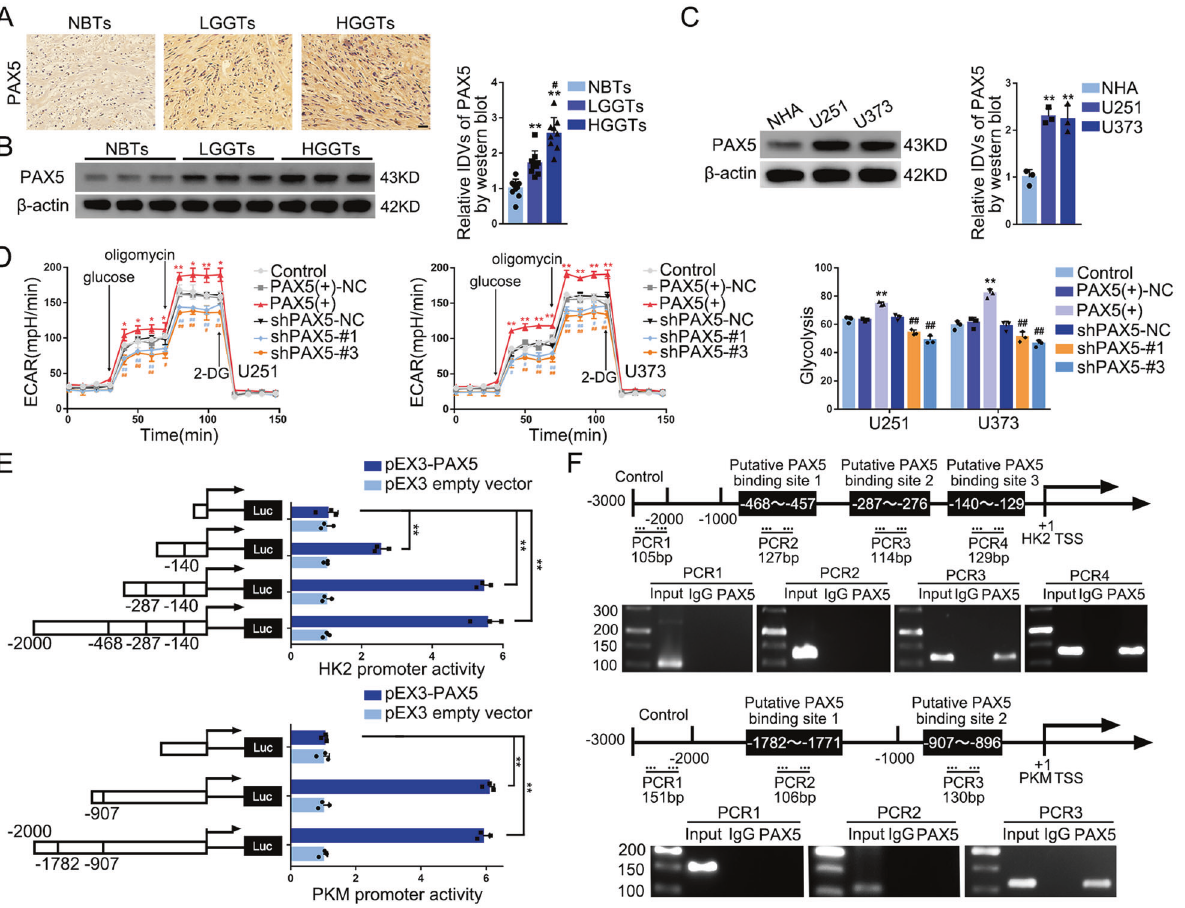
Fig. 5 PAX5, upregulated in GBM Cells, facilitated Glycolysis and Proliferation by Transcriptionally promoting HK2 and PKM2 Expression. A IHC shows the expression and distribution of PAX5 in NBTs, LGGTs, and HGGTs (×200; scale bar represents 150 µm). B NBTs deriving from regions adjacent to the GBM and GBM tissues of different grades (LGGTs, HGGTs) were analyzed for PAX5 protein levels by western blotting. The IDVs of the bands were statistically analyzed. Data are manifested as mean ± SD ( n = 9, each group). ** P < 0.01, compared with NBTs group; # P < 0.05 compared with LGGTs group. C Expression of PAX5 in NHA, U251, and U373 cells. The IDVs of the bands were statistically analyzed. Data are manifested as mean ± SD ( n = 3, each group). ** P < 0.01 compared to NHA group. D Effects of PAX5 overexpression or knockdown on ECAR in U251 and U373 cells were determined. Data are presented as mean ± SD ( n = 3, each group). * P < 0.05, ** P < 0.01 compared with PAX5( + )-NC group; # P < 0.05, ## P < 0.01 compared with shPAX5-NC group. Glycolytic capacity and glycolytic reserve in